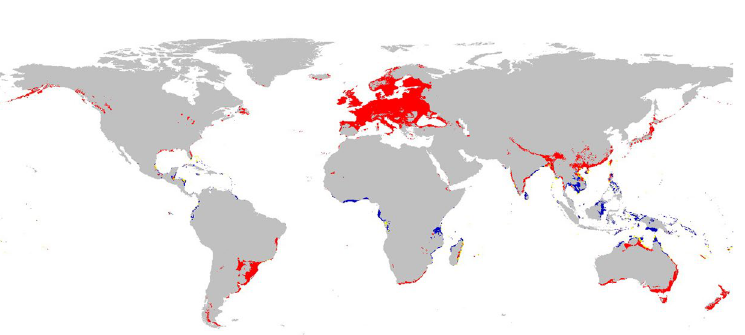
Figure 5. ENM predicted distribution regions for Guettarda speciosa (green), Agrius convolvuli (yellow) and Ipomoea pes-caprae (blue) in 10th percentile training presence. Red color highlights the overlapping areas of the three species, and black dots indicate the occurrence records of G . speciosa . Figures B and C illustrate the details of the regions in the dashed boxes in figure A. Red dashed circle in figure C highlights the experimental site, Yongxing Island.